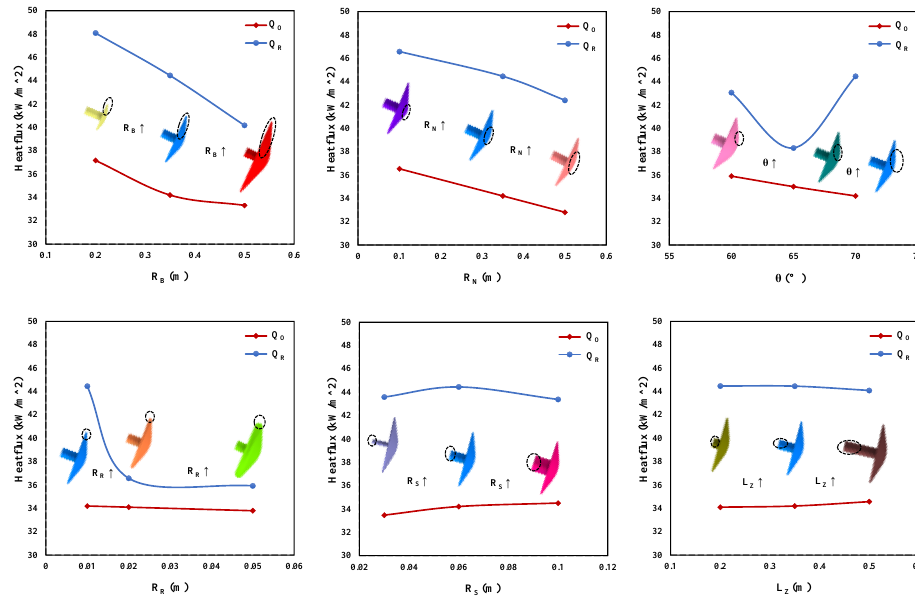
Figure 20. Influence law of structural parameters on surface heat flux.